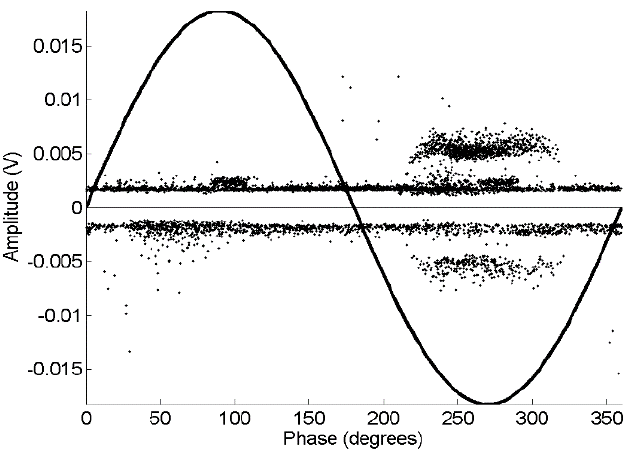
Figure 5. Typical PRPD pattern with several types of partial discharges and noise (taken from [20]). Table 1. Sizes of the pulses sets used in the experimental work.